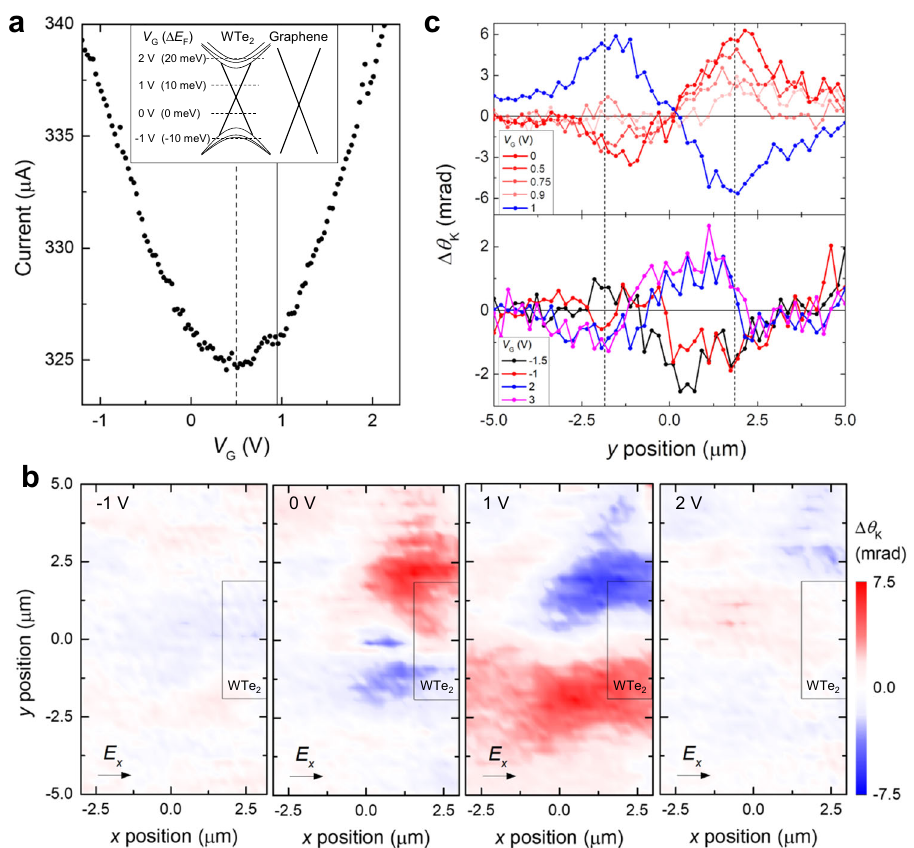
Fig. 2 | Gate voltage dependence of the spatially resolved differential Kerr rotation.a The V G -dependentdraincurrentparalleltothe a -axisofWTe 2 isshown. Themeasurementswereperformedat1.6K.Thelongitudinalbiasvoltagewas0.5V between contact 1 and 3 (parallel to the a -axis; see Fig. 1c for the contact number). Two charge neutral points were observed; one at V G =0.5V is for graphene (black dashed line) and another at V G =0.95V is for WTe 2 (black line). The illustration in the inset shows the schematic band alignment of graphene and WTe 2 . Repre- sentative V G andthecorrespondingFermilevelchange 4 E F aremarkedastheblack dashed lines. b Spatially resolved contour plots of the V G -dependent Δ θ K . The